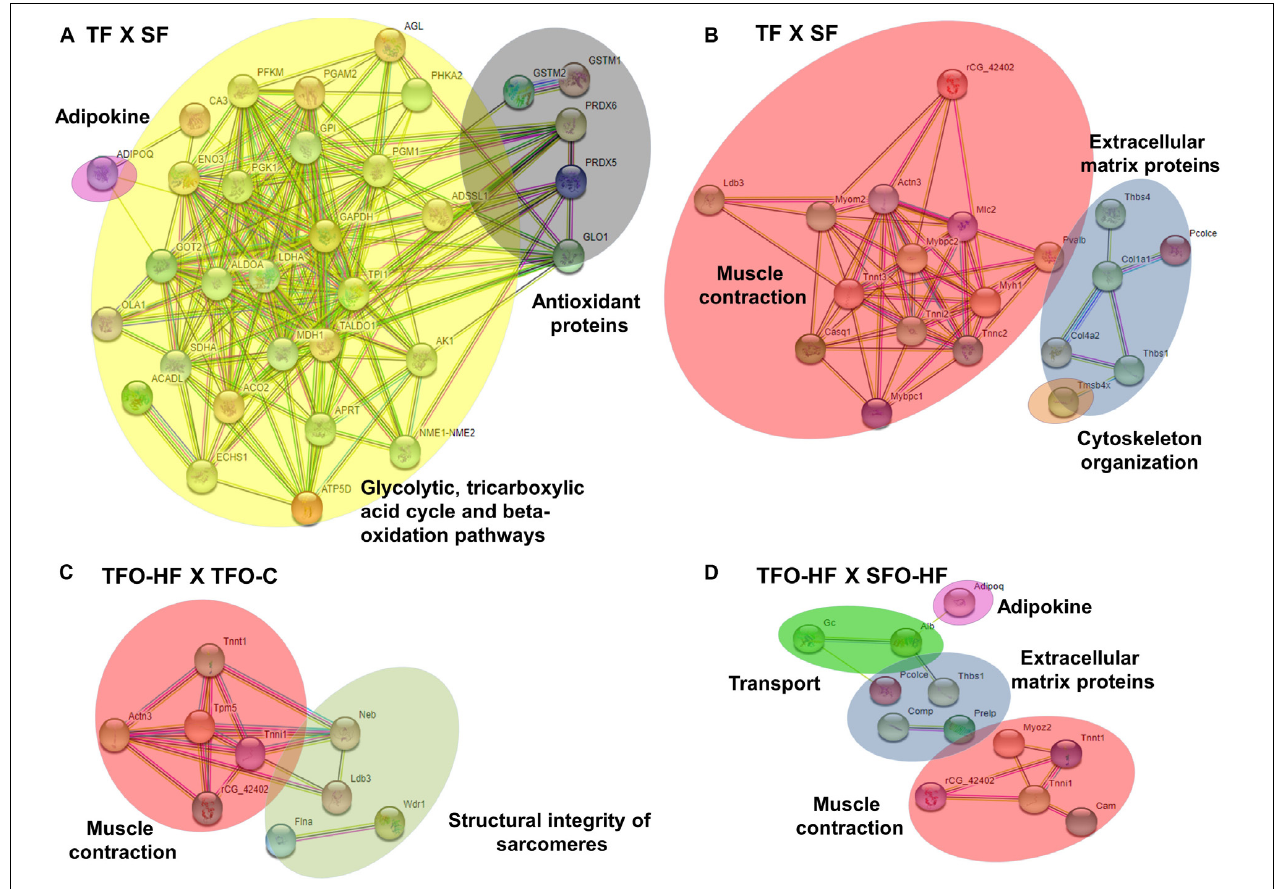
FIGURE 7 | Protein-protein interaction analysis based on STRING network analysis with an interaction confidence score of 0.4. SF, sedentary fathers; TF, trained fathers; TFO-C, offspring from trained fathers exposed to control diet; SFO-HF, offspring from sedentary fathers exposed to high-fat diet; TFO-HF, offspring from trained fathers exposed to a high-fat diet. STRING analysis for differentially abundant proteins in the fathers (A,B) and offspring groups (C,D) . All altered proteins are grouped according to their biologic process as noted in Gen Ontology (GO).Primary metabolism (yellow), adipokine (pink), oxidation-reduction process (dark gray) and muscle contraction (red), sarcomere organization (light gray), cytoskeleton organization (orange) and extracellular matrix organization (blue), transport